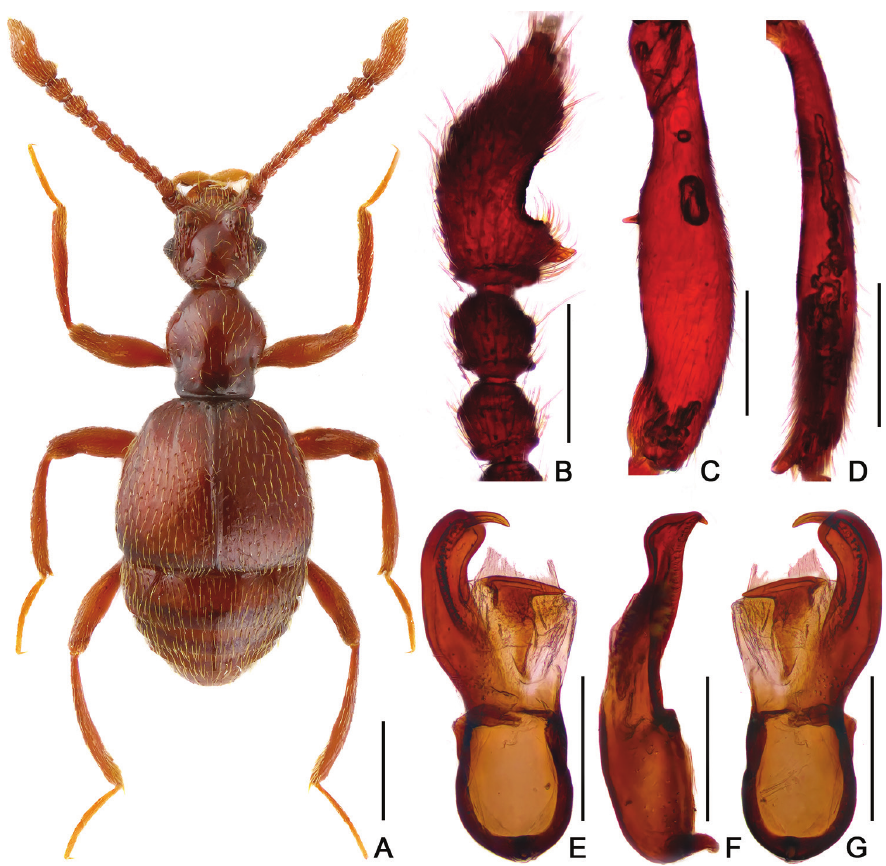
Figure 7. Diagnostic features of Batrisodes tianmuensis , male. A Dorsal habitus B Antennal club C Mes- otrochanter and mesofemur D Mesotibia E–G Aedeagus, in ventral ( E ), lateral ( F ), and dorsal ( G ) views. Scale bars: 0.5 mm ( A ); 0.2 mm ( B–G Batrisodes xuhaoi sp. n.